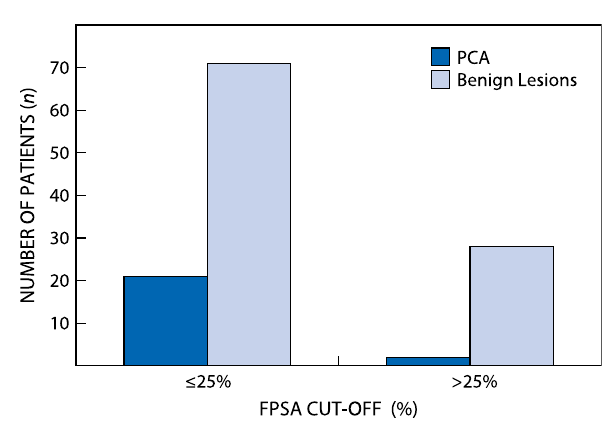
Figure 2: Diagnosis based on 25% FPSA ratio and histology.